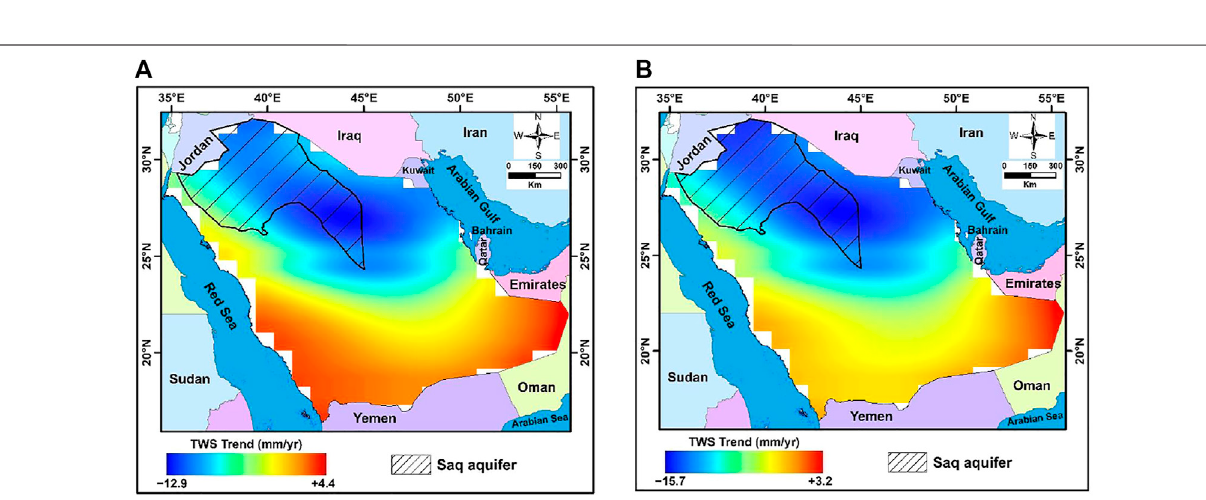
Frontiers in Earth Science |